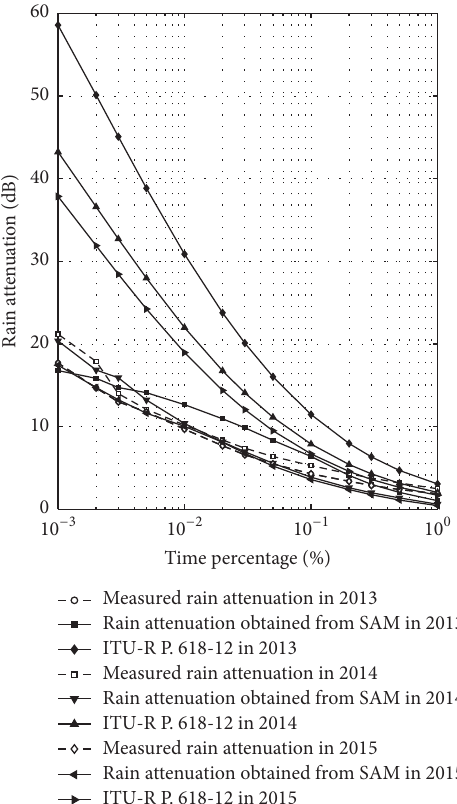
Figure 7: Comparison between empirical measured data and ITU- R P. 618-12 at 19.8 GHz [20]. Figure 8: Comparison between empirical measured data and ITU- R P. 618-12 at 20.73 GHz